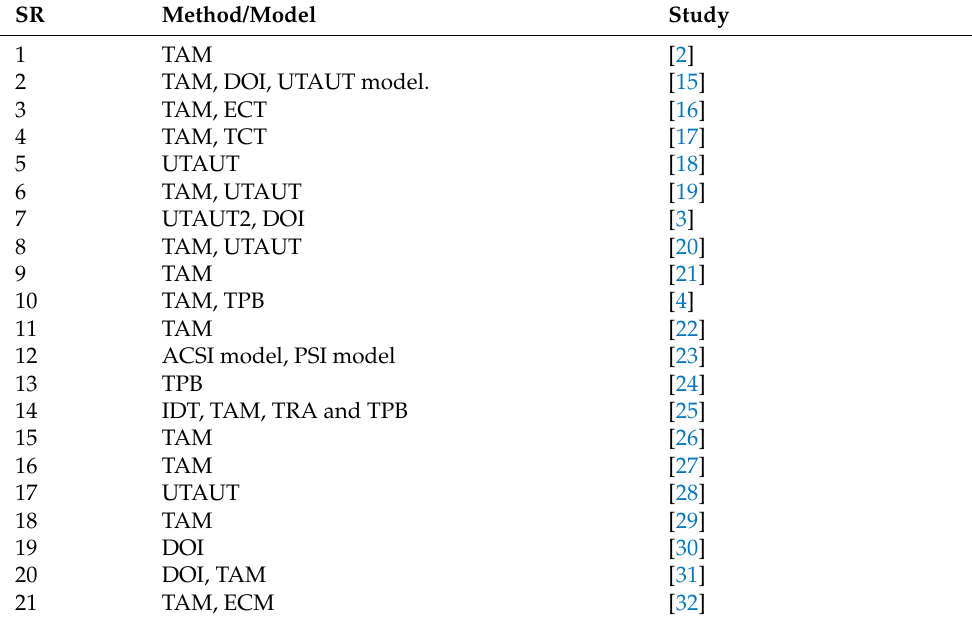
Table 2. Models used In Literature.